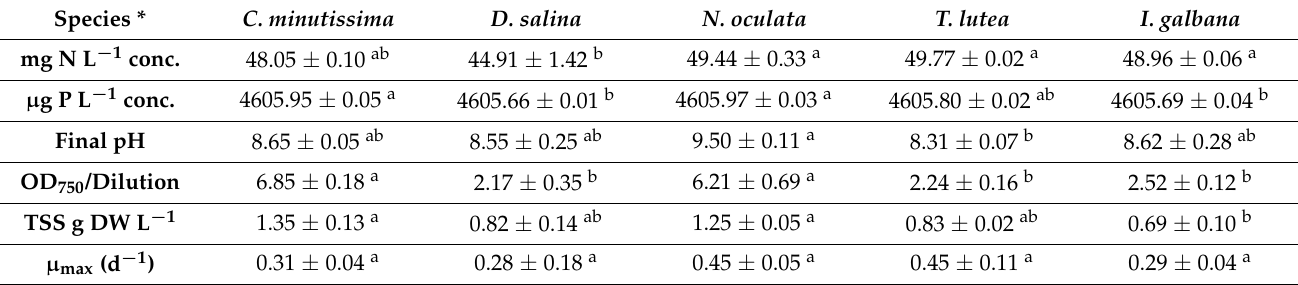
Table 1. Nutrient consumption, pH, final OD 750 , final TSS, and µ max ± the standard deviation.